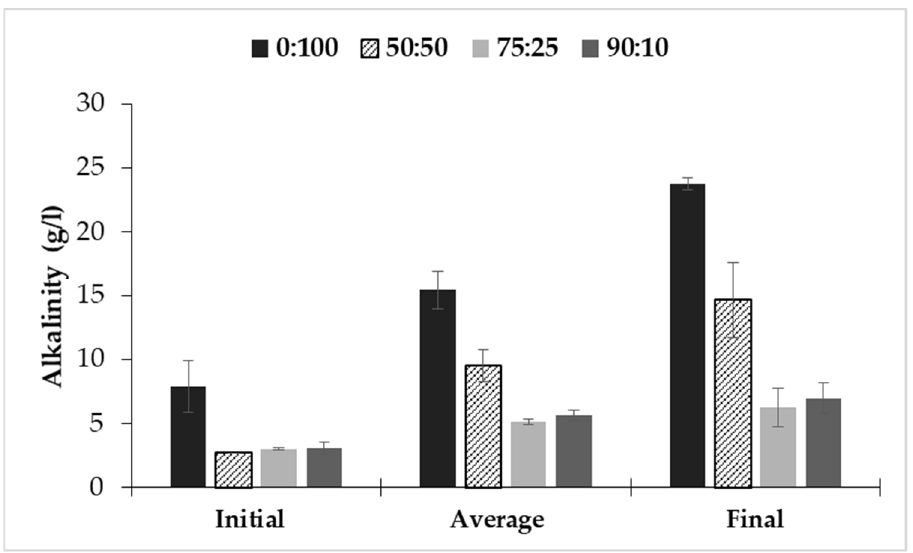
Figure 3. Alkalinity of the anaerobic co-digestion process of CM and ESBP. The initial alkalinity levels for the different substrate mixtures (CM: ESBP) ranged between 2.64 and 3.50 g/L. These values can be considered adequate. Thus, Lorenzo and Obaya [33] reported that the alkalinity in an AD process should be close to 2 g/L. As can be seen in Figure 3, the alkalinity increases in all the tests from the initial to the final stage. The increase is related to the production and solubilization of carbon dioxide in the medium in addition to the amounts of potassium carbonate added. Therefore,